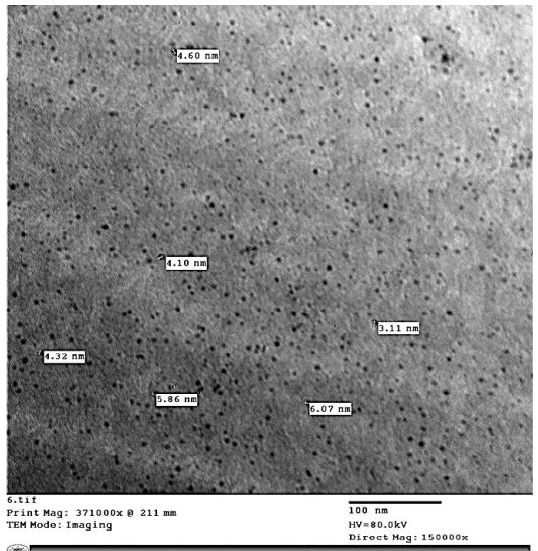
Figure 2. Silicon nanoparticles.